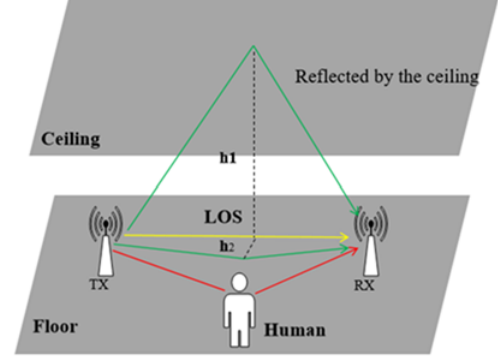
Figure 3. Indoor multi ‐ path effect model.